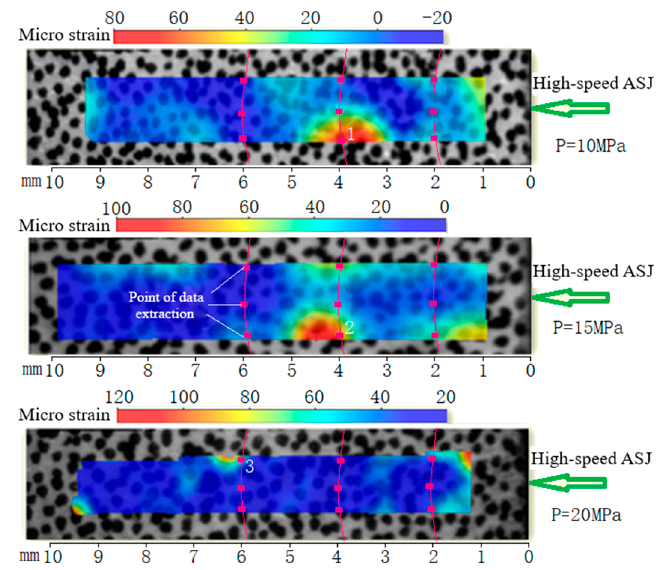
Figure 4. Strain distribution of rock impacted by ASJ with various pressures.